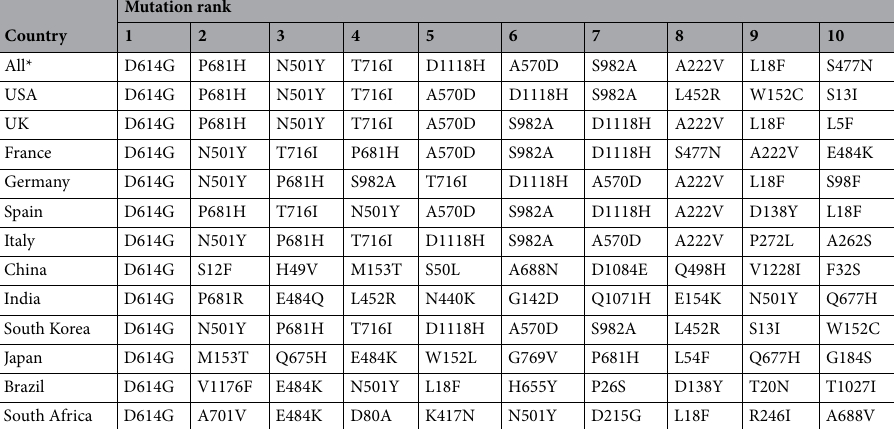
Table 1. The top 10 mutations (after the D614G mutation, the first divergence from the “Wuhan 2019” sequence which arose rapidly and is present throughout the world at high frequency) in the spike protein listed in order of their frequency in sequences from all countries, and twelve different countries. The most common alterations are P681H (near the furin cleavage site that is a major distinction between SARS-CoV-2 and SARS) and N501Y (in the ACE2 binding region of the RBD). *All SARS-CoV-2 sequences in the GISAID